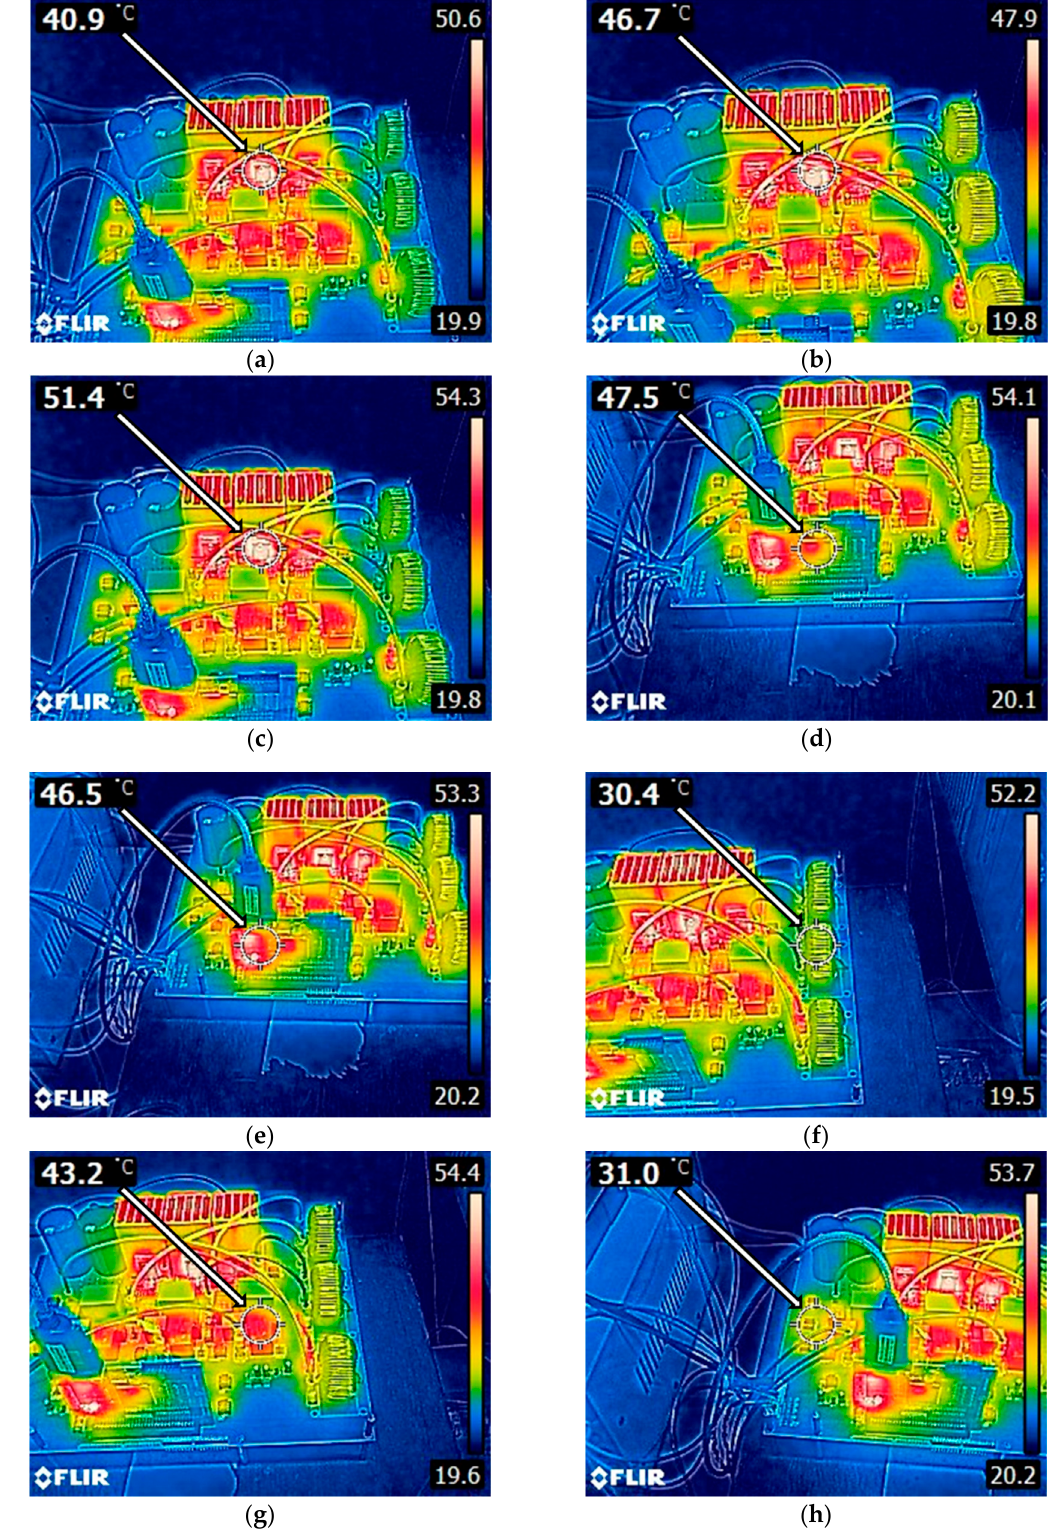
Figure 27. Thermographic photos of the proposed GaN-based three-phase APF prototype: ( a ) TPH3207 device switching at 50 kHz; ( b ) TPH3207 device switching at 80 kHz; ( c ) TPH3207 device switching at 100 kHz; ( d ) DSP; ( e ) communication interface; ( f ) inductors; ( g ) relay; ( h ) signal processing integrated circuits (ICs). Table 6. Summary of operating temperatures of individual devices.